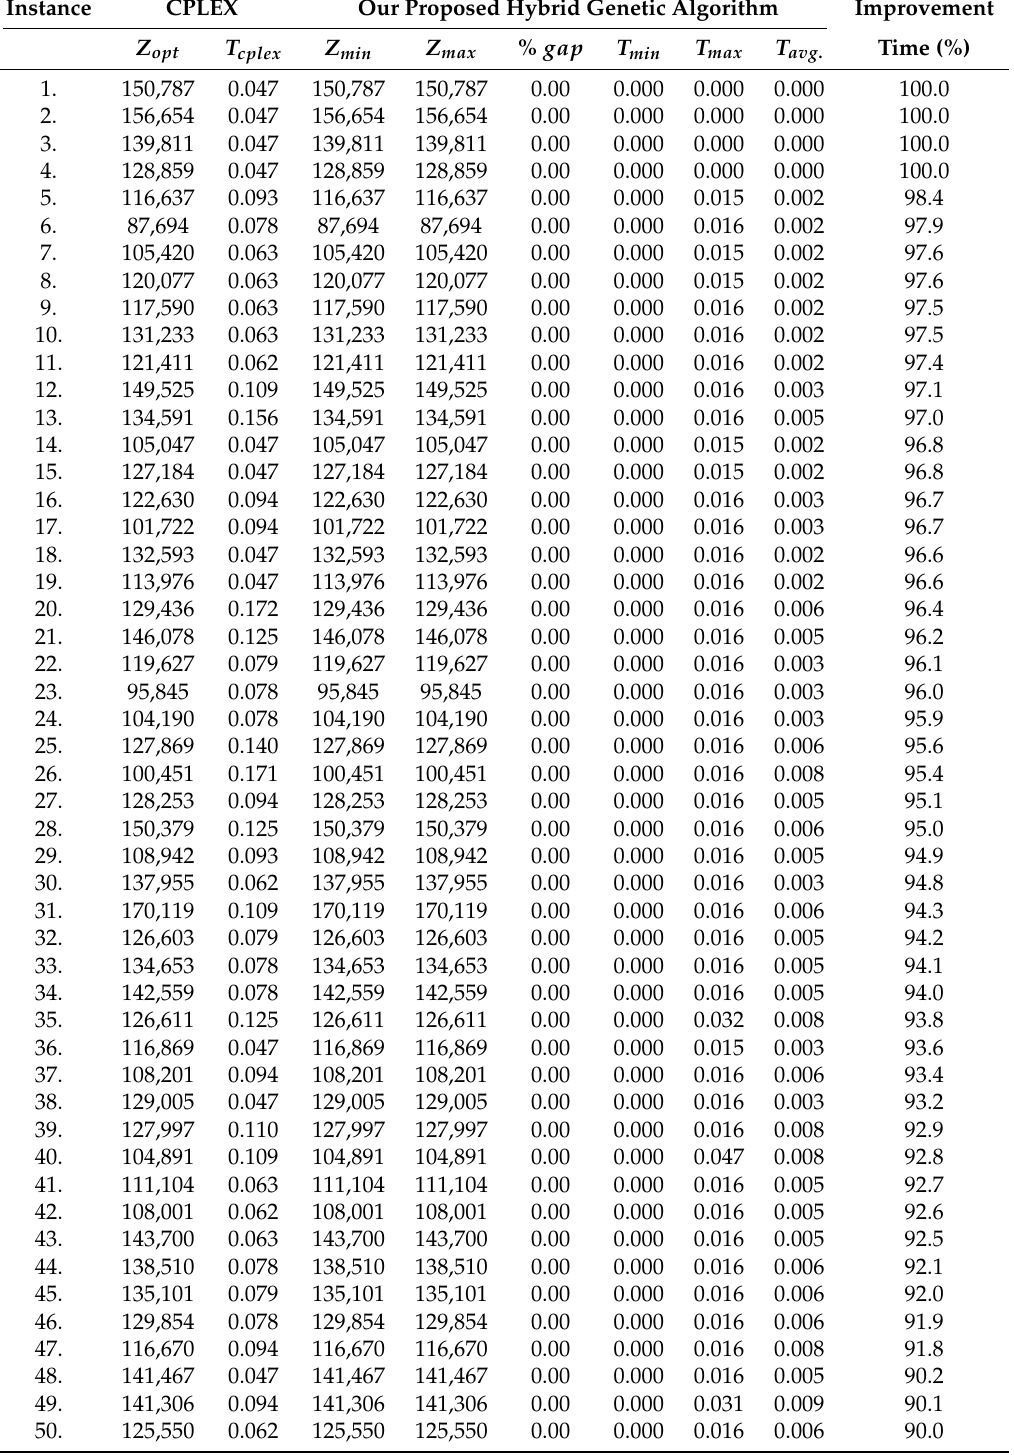
Table 1. Computational results achieved in the case of small sized